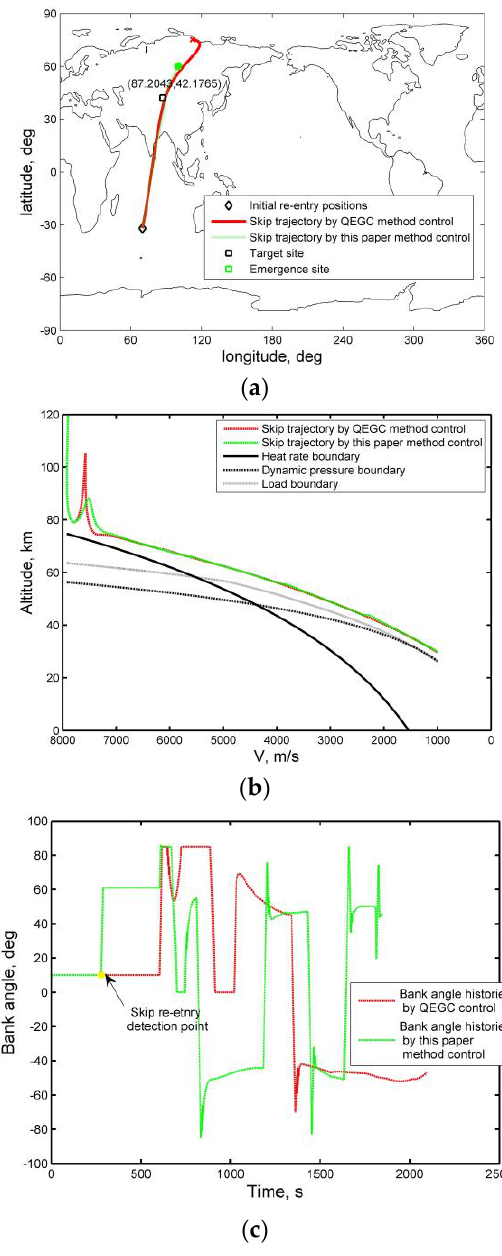
Figure 14. Comparison of quasi-equilibrium glide condition (QEGC) method and the proposed solution in an abnormal skip re-entry scenario: ( a ) lateral histories, ( b ) velocity–altitude histories, and ( c ) bank angle histories.